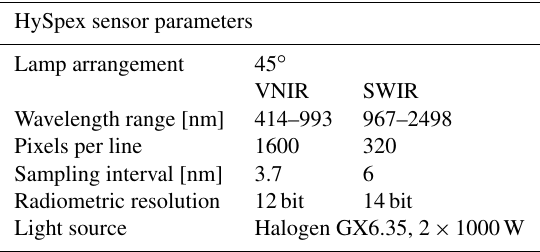
Table 1. HySpex sensor parameters of the VNIR-1600 (VNIR) and SWIR-320m-e